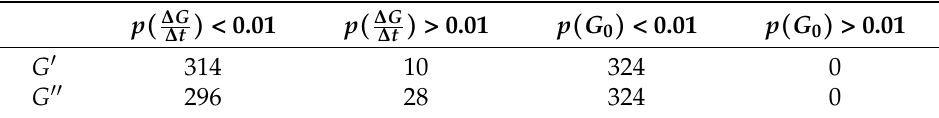
Table 5. Statistical significance for the approximation of G (cid:48) and G (cid:48)(cid:48) with drift effects using a linear ∆ G function with a slope ∆ t and an intercept G 0 .